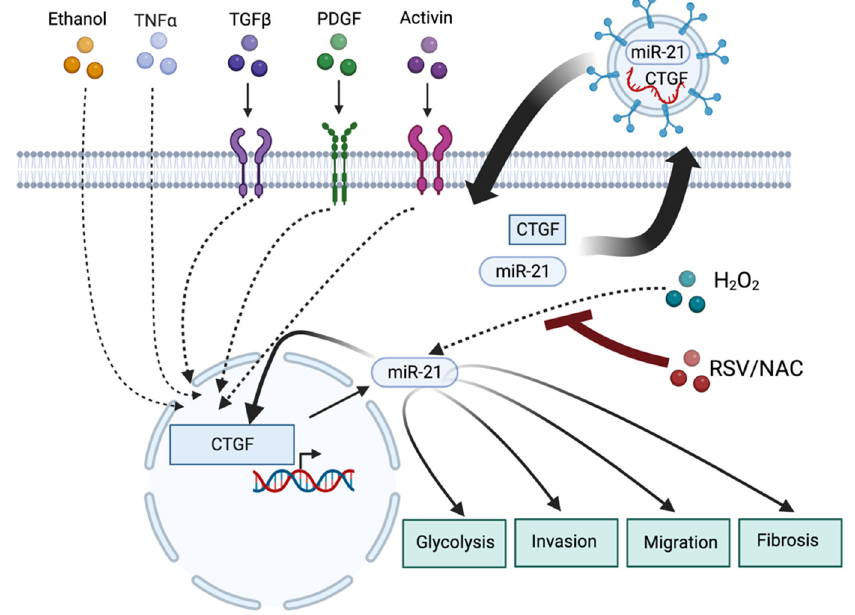
Figure 7. MiR-21 plays a crucial role in the activation, glycolysis, fibrosis, migration, and invasion of PSCs in CP (please see text for details). Created with BioRender.com.